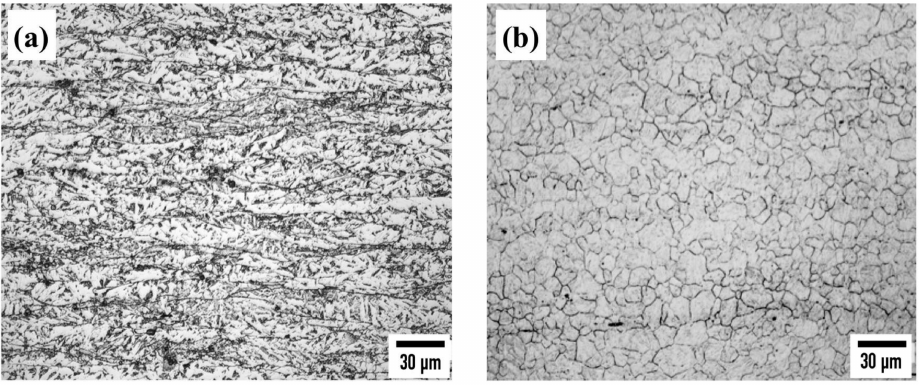
Figure 7. Parent austenite grain morphology of Mo + Nb alloyed 22MnB5 steel after hot rolling ( a ) and after re-austenitizing quenching ( b ).